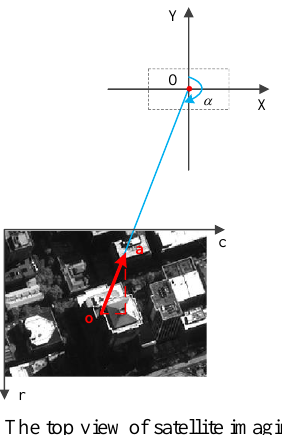
Figure 2. The top view of satellite imaging scene